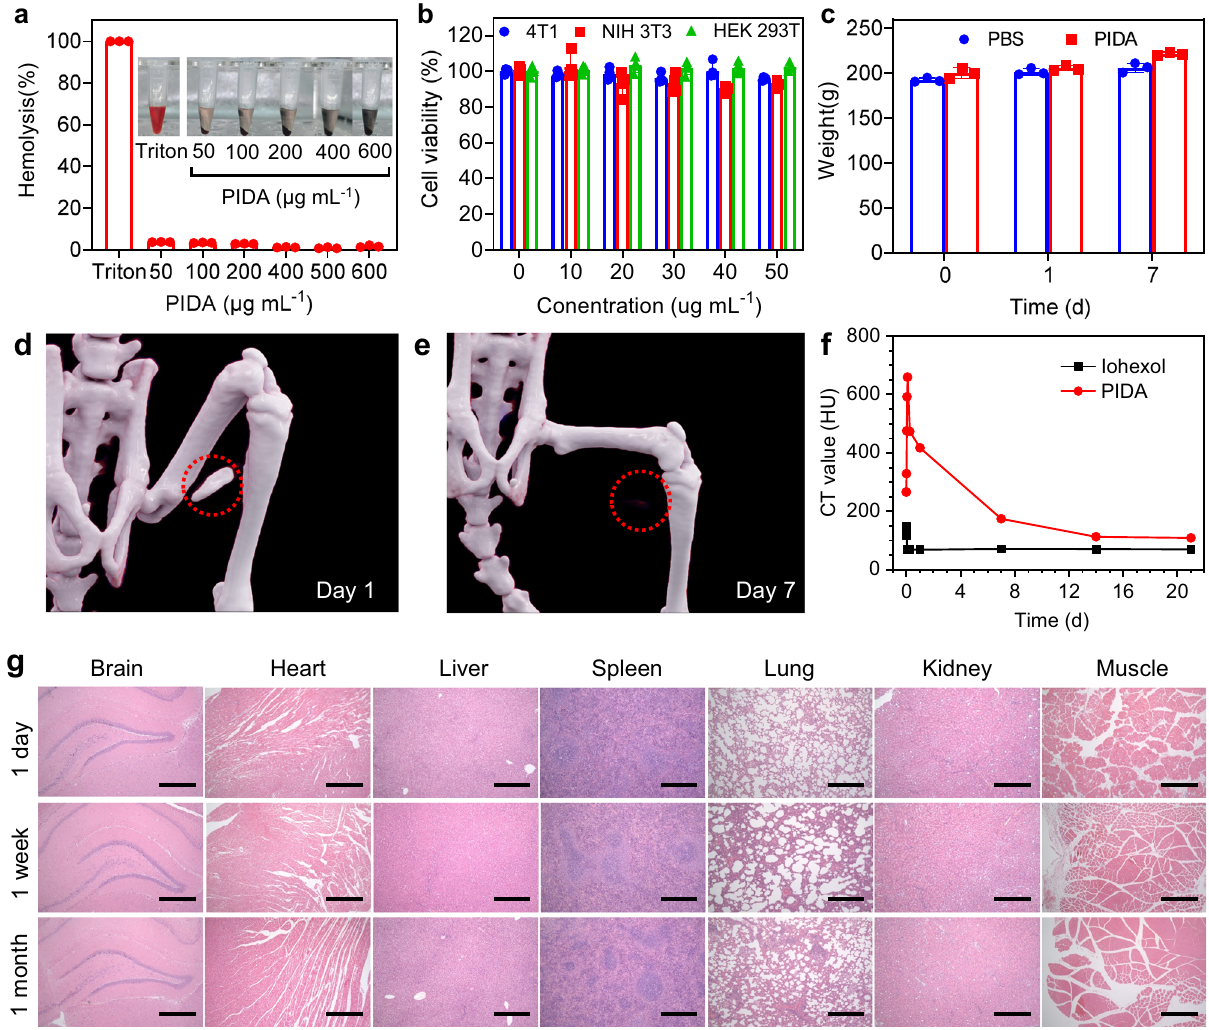
Fig. 6 Biosafety assessment of PIDA. a Hemolysis assay and images (insert) of RBCs incubated with different samples ( n = 3 biologically independent samples). The percentage of RBC lysis was <5% for PIDA . b Viability of 4T1, NIH 3T3, and HEK 293 T cells pretreated with a series of doses of PIDA (n = 4 biologically independent samples). c . Body weights of rats received the treatment and control rats (n = 3 biologically independent samples). d , e CT images of PIDA in muscle at different time after injection. f Plots of CT values of PIDA and iohexol ([I]: 4 mg mL − 1 , 200 μ L) injected in rats as a function time. g H&E staining of main organs after being injected with PIDA. The experiment was repeated 3 times independently with similar results. Scale bars: 0.5 mm. All data are presented as Mean ± SD. Source data are provided as a Source Data Methods Synthesis of monomer diiodobutadiyne . The monomer diiodobutadiyne (IDA) was synthesized through the reaction between 1,4-bis(trimethylsilyl)-1,3-butadiyne and N -iodosuccinimide catalyzed by silver nitrate 46 . 1,4-Bis(trimethylsilyl)-1,3- butadiyne (194.6 mg, 1mmol) was dissolved in 30mL of acetone. Silver nitrate (130.5 mg, 0.75 mmol) and N -iodosuccinimide (550.6 mg, 2.37 mmol) were added to the solution. The reaction fl ask was wrapped by aluminum foil to avoid the interference of ambient light. The reaction was stirred at room temperature for 4.5h. (The completion of the reaction was con fi rmed by thin layer chromato- graphy). After the reaction, the sample was extracted with n-hexane/water. The extraction process was repeated three times. The upper organic phase was dried with anhydrous sodium sulfate and concentrated in vacuo under ice bath. A light- yellow solid product was obtained (280 mg, yield 93%). 13 C NMR (100MHz, CDCl 3 ) δ (ppm): 79.86, − 3.18 46 . Synthesis of 1 . 2-(Pyridin-3-yl)ethan-1-amine (2.566 g, 21mmol) was dissolved in 10mL of acetone, and diethyl oxalate (1.461 g, 10 mmol) was added dropwise under stirring at room temperature 54 . After 6h of reaction, the solvent was removed under vacuum. 40 mL of methanol was added to the remaining solid and heated to 50°C to form a clear solution. The crystals gradually precipitated out of the solution at room temperature in 24 h. After removing the excess solution by fi ltration, the remaining solid was washed with cold methanol to obtain white